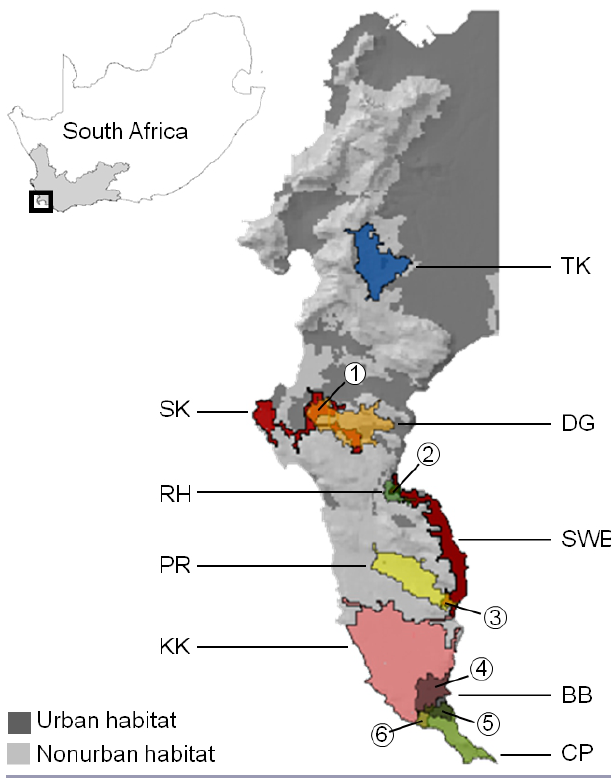
Fig. 1 . The location of the Cape Peninsula in South Africa (inset) and the home ranges of the nine chacma baboon troops included in this study. Encircled numbers indicate areas of spatial home range overlap, and correspond to the pair number column in Table